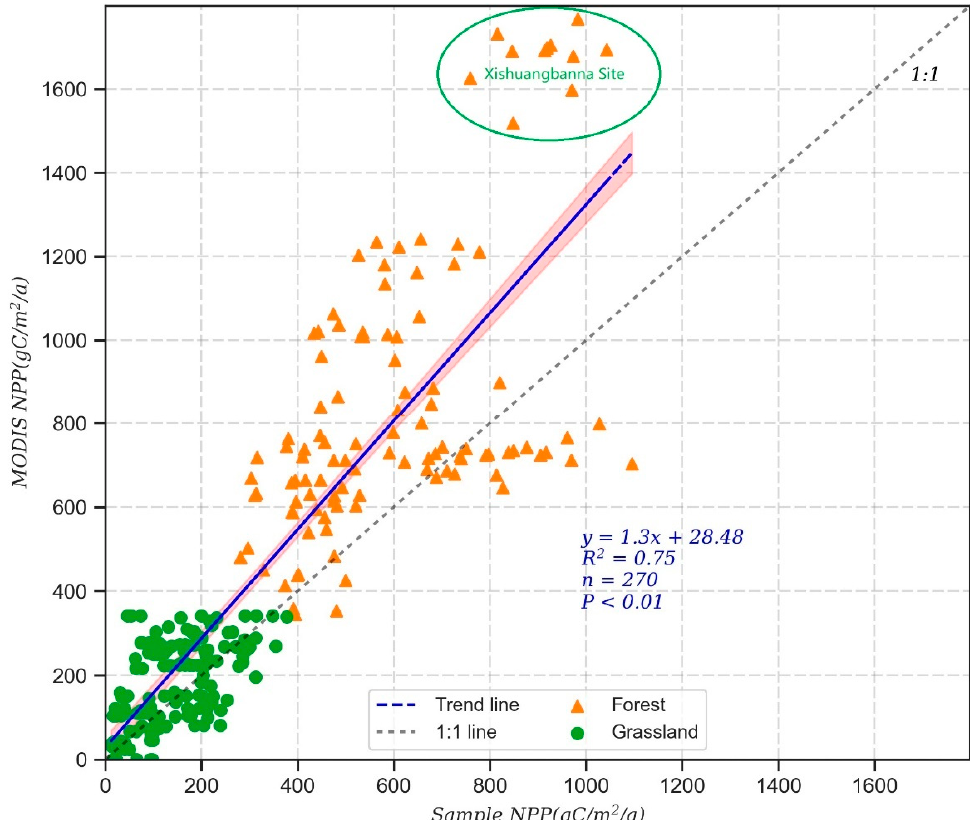
Figure 5. The NPP from MOD17A3HGF v006 compared with sample